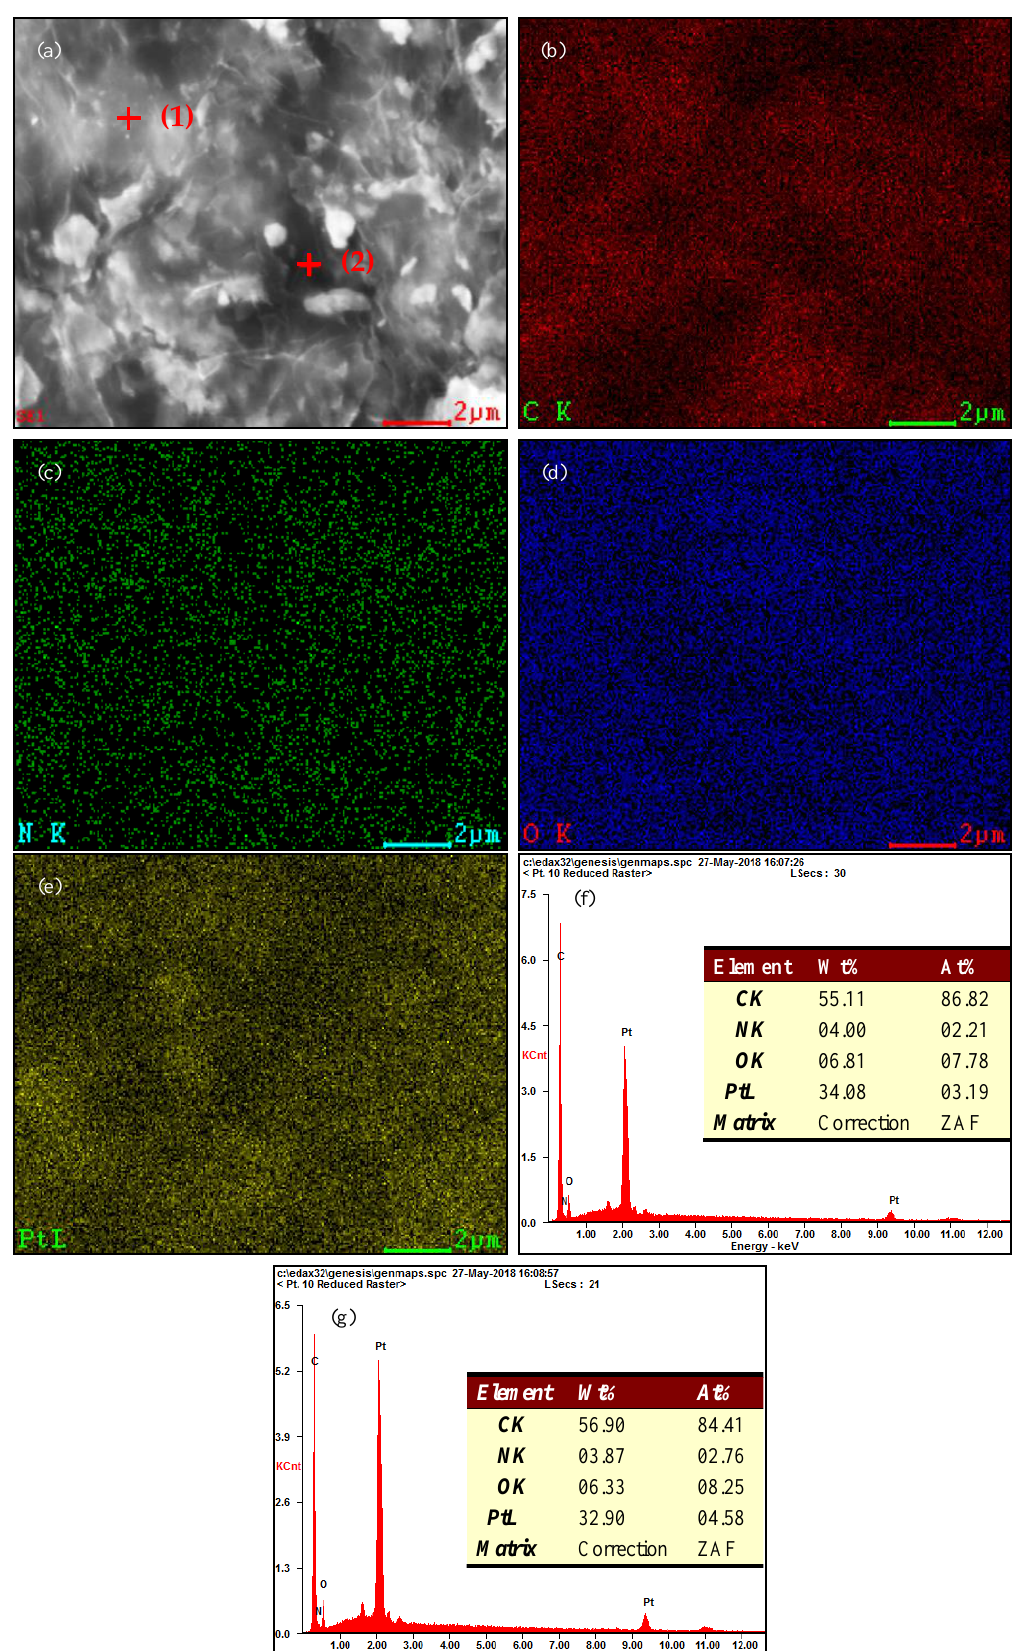
Figure 5. ( a ) SEM image; ( b – e ) plane scan analysis; ( f , g ) EDS analysis from ( a ) of catalyst 6#.